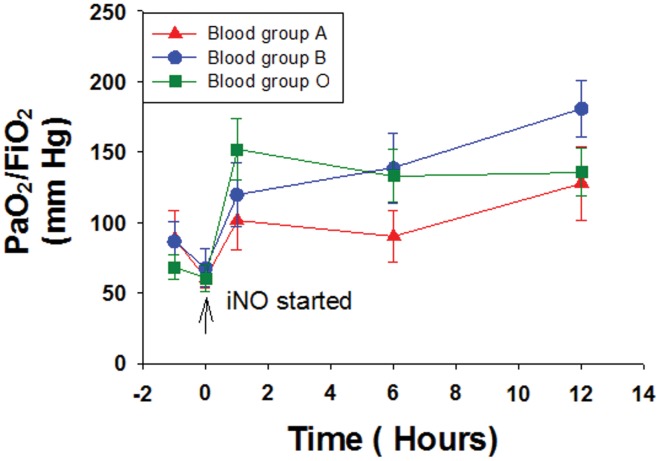
Magnitude of response in PaO2/FiO2 in relation to blood group at various time points before and after initiation of iNO. (mean±SE; n = 18 for group A, 18 for group B, and 36 for group O).By Repeated Measures ANOVA, p<0.01 for blood groups B and O, and p = 0.18 for blood group A for changes in PaO2/FiO2 over time.